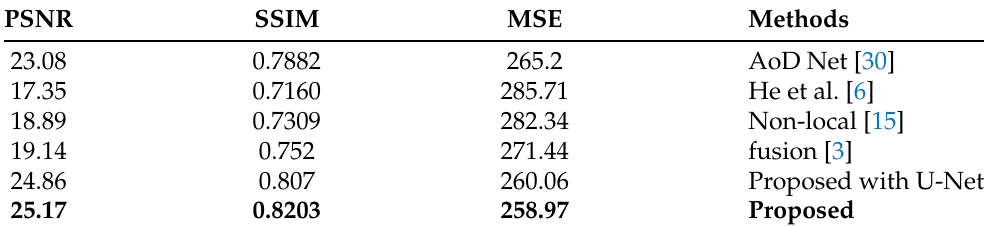
Figure 7. Example of the extreme single image dehazing operation. Table 1. Quantitative comparison for the RESIDE dataset [2].